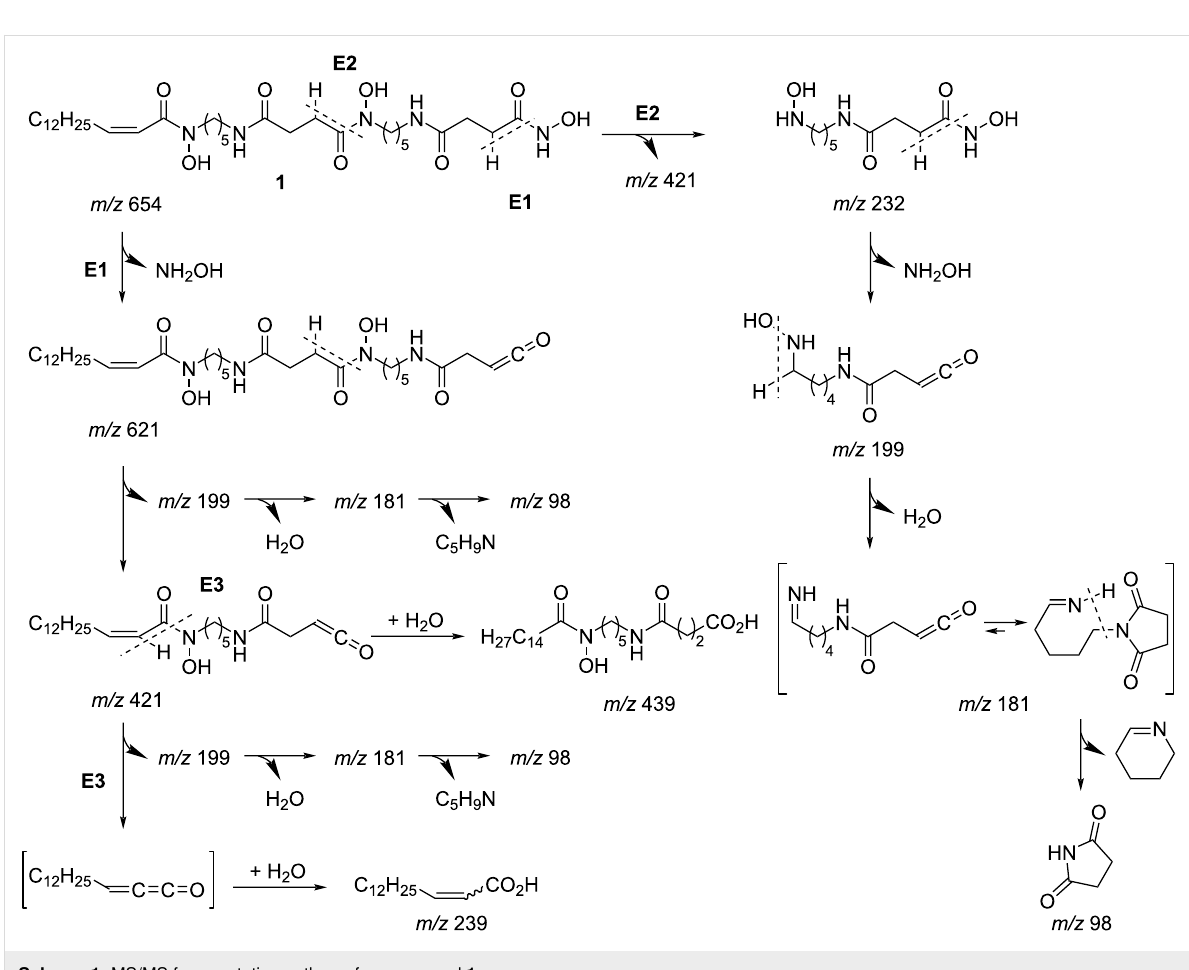
Scheme 1: MS/MS fragmentation pathway for compound 1